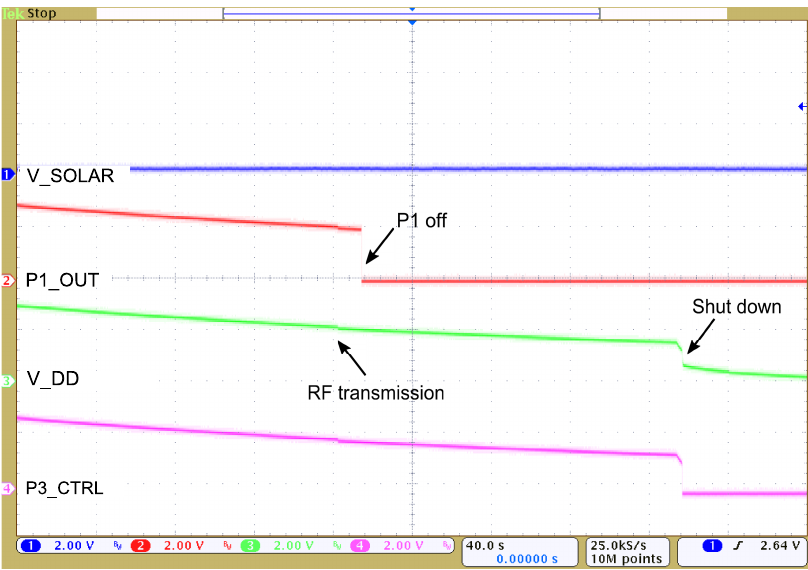
Figure 8. Shut down process. Waveforms are acquired at points denoted in Figure